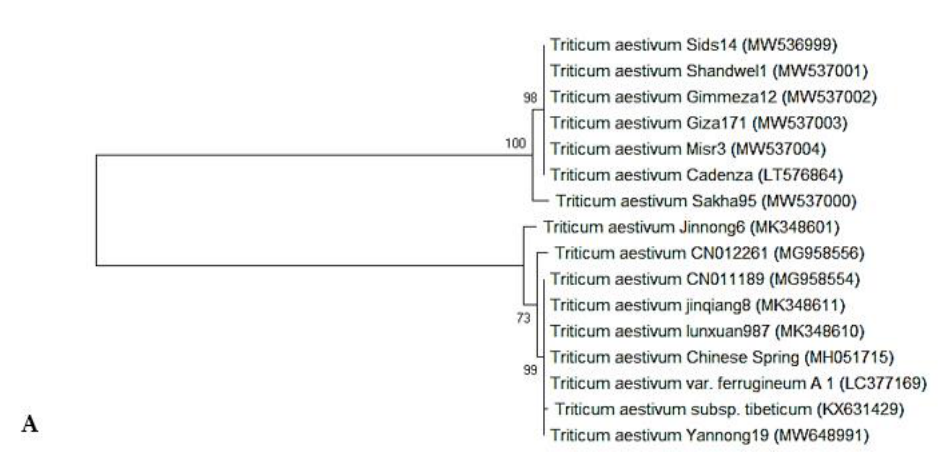
Figure 8. Maximum likelihood tree analysis UPGMA of 6 selected T. aestivum genotypes: W16 (MISR 3), W3 (SIDS 14), W7 (GIZA 171), W4 (SHANDWEEL1), W13 (GEMMIZA 12) and W6 (SAKHA 95) and 10 NCBI outgroups, using MEGAX software based on ( A ) rbcL sequence data of and ( B ) matK sequence data. Numbers indicated on the similarity percentage and the organism accession num- bers represented in parentheses. 4. Conclusions Significant differences in morphological and phenological traits indicated a high level of genetic variability in wheat genotypes, which could be used in future breeding programs for wheat genotype improvement and development. Further- more, the high polymorphism percentage obtained by ISSR and SCoT